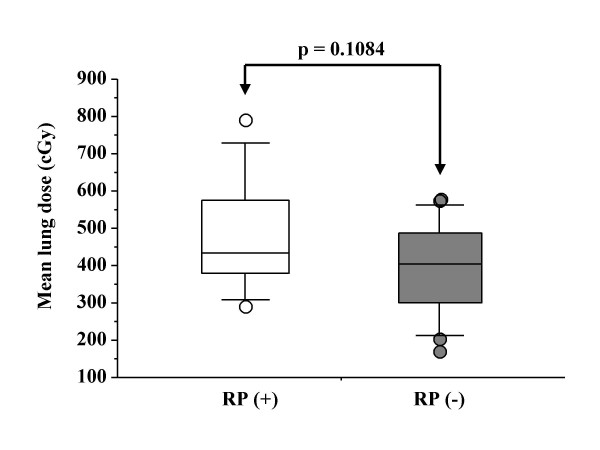
The correlation comparing the occurrence of RP grade 2 or more with MLD.